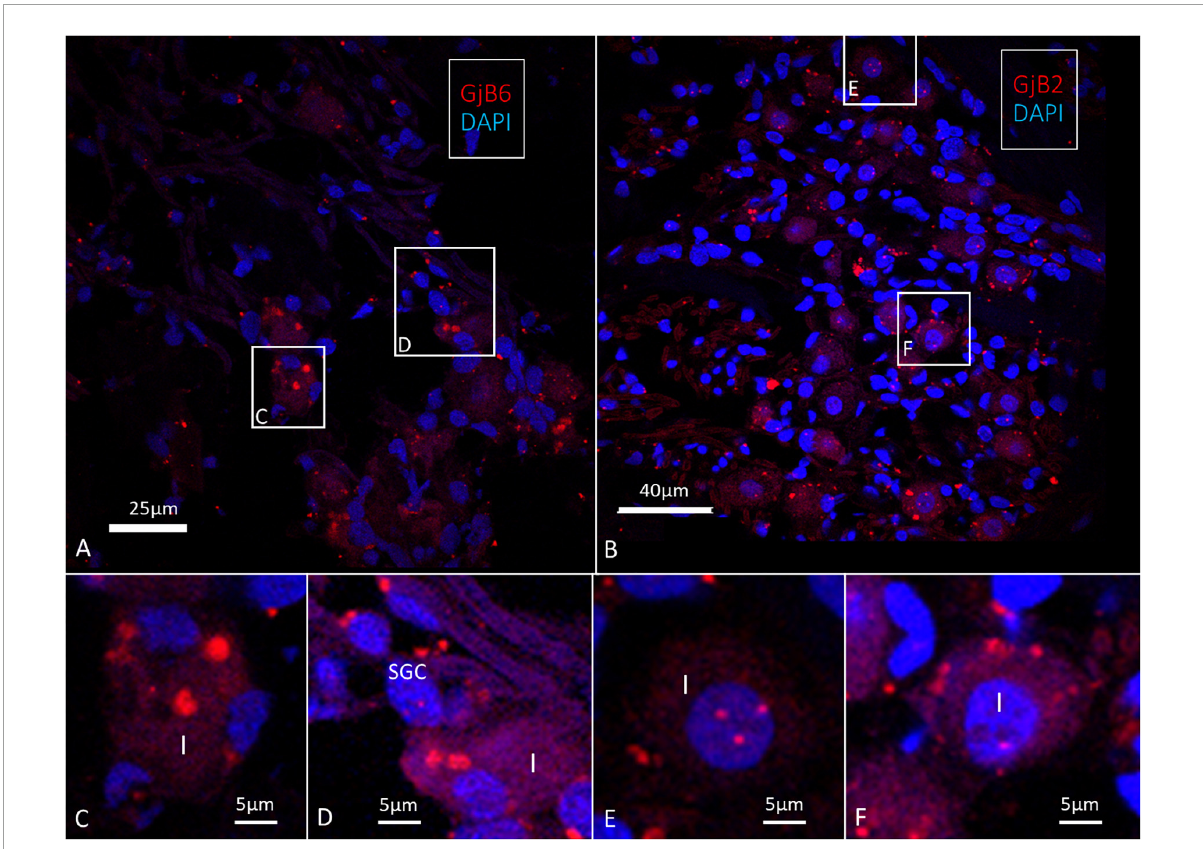
FIGURE11 Confocal microscopy of GJB2 and GJB6 transcripts in the human spiral ganglion. (A) Occasional GJB6 transcript puncta are seen in the type I ganglion cells and a few puncta can be seen in the surrounding cells, including the satellite glia cells (SGC). Framed areas are magnified in (C,D) . (B) A few GJB2 gene transcript puncta are seen in the type I ganglion cell soma. Framed areas are shown in higher magnification in (E,F) . (E) Type I cell nucleus contains GJB6 transcripts (F) . A type I cell contains GJB6 puncta. Larger red-stained areas (non-puncta) are considered to be